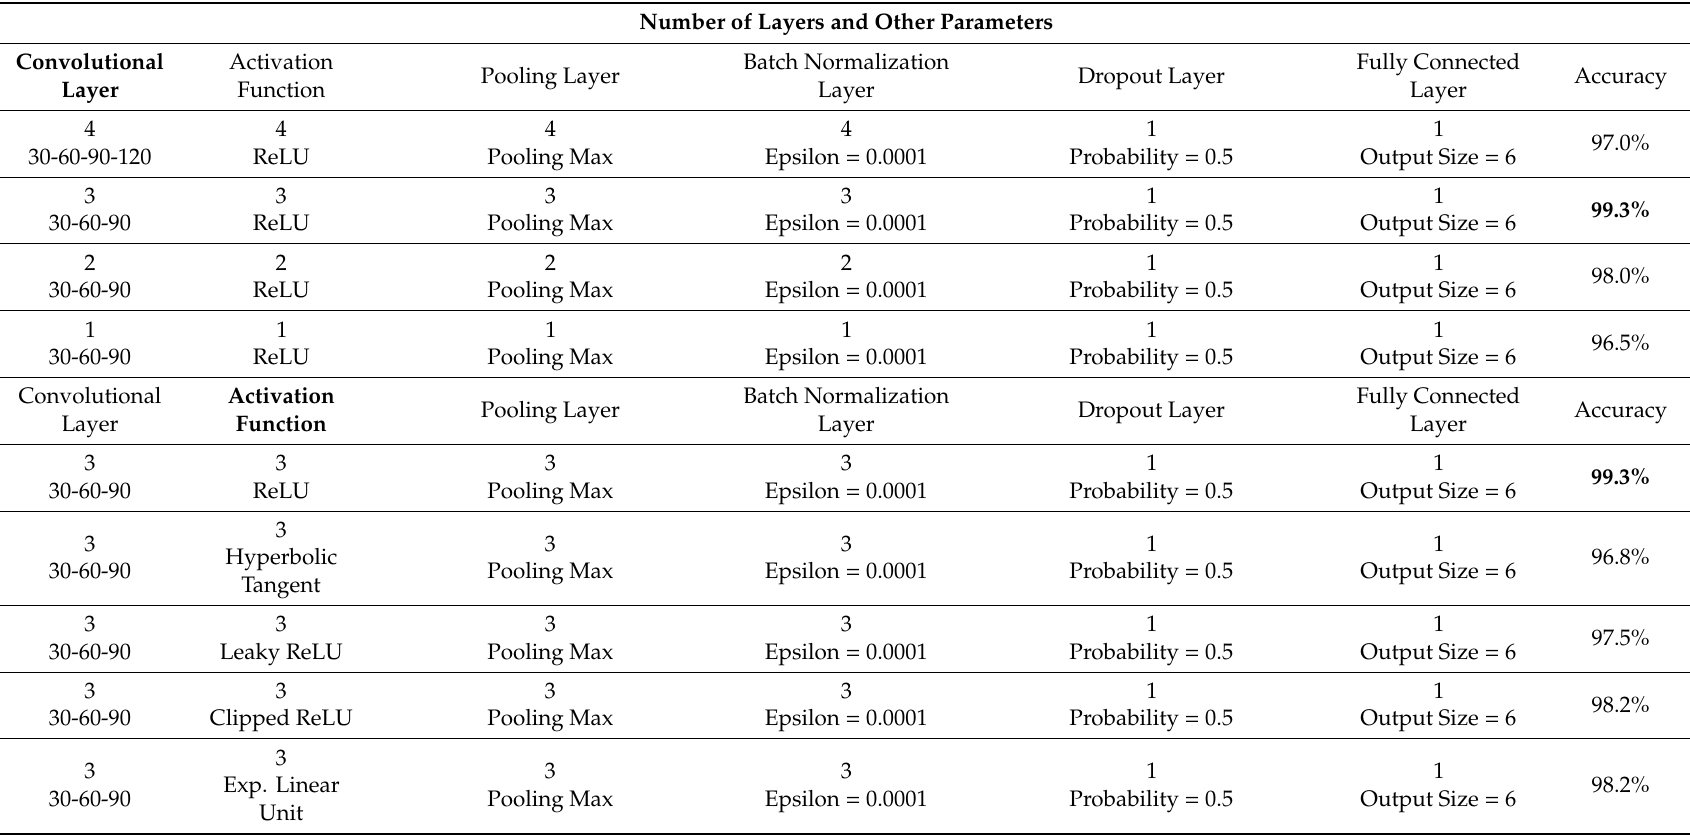
Table 2. The e ff ect of the parameters of the neural structure on the e ff ectiveness of the CNN-based damage detector. Number of Layers and Other